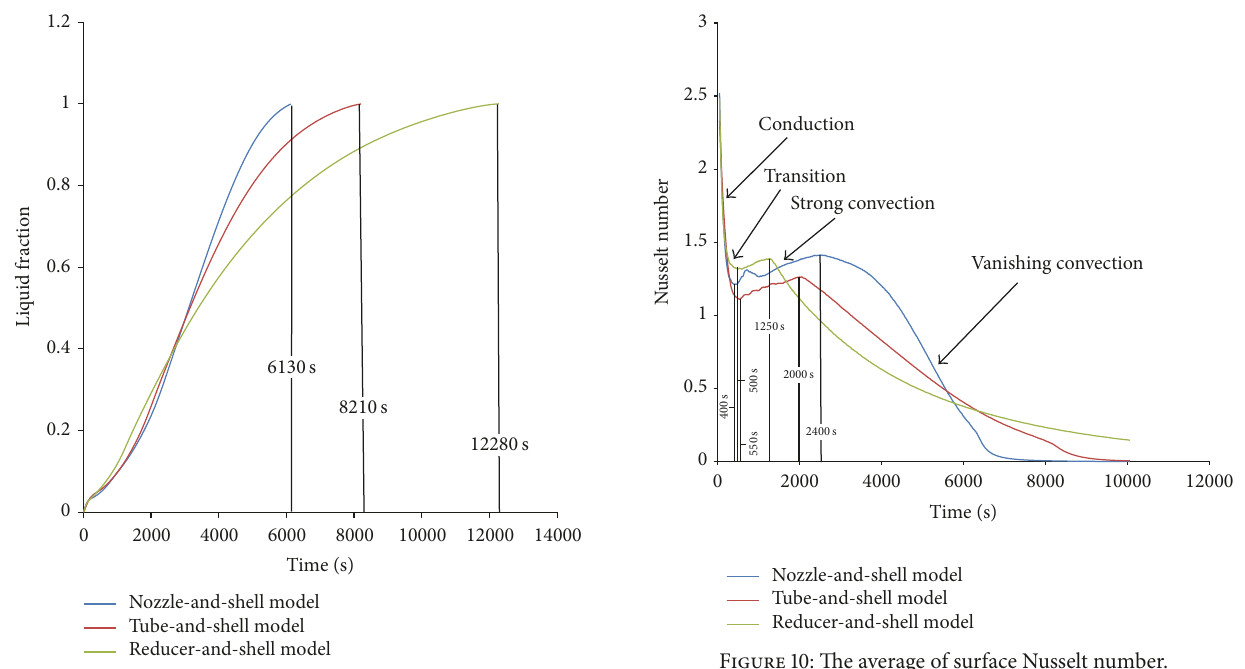
the tube-and-shell model, the nozzle-and-shell model was 15.3% faster, and the reducer-and-shell model was 49.5% slower.